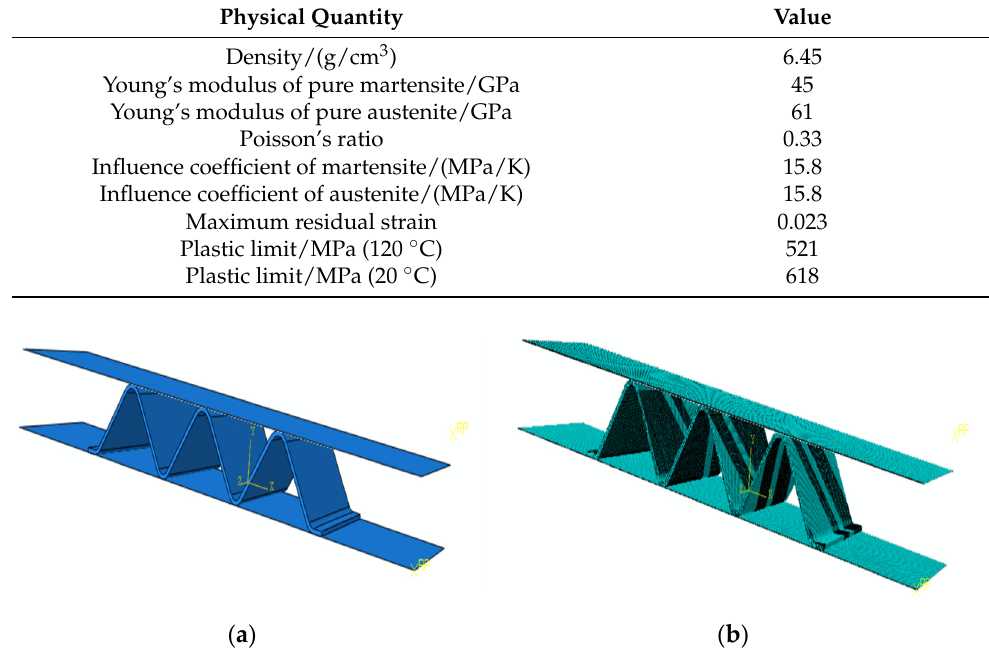
Figure 5. Finite element model of the NiTi alloy corrugation: ( a ) Geometrical model; ( b ) Geometrical model.